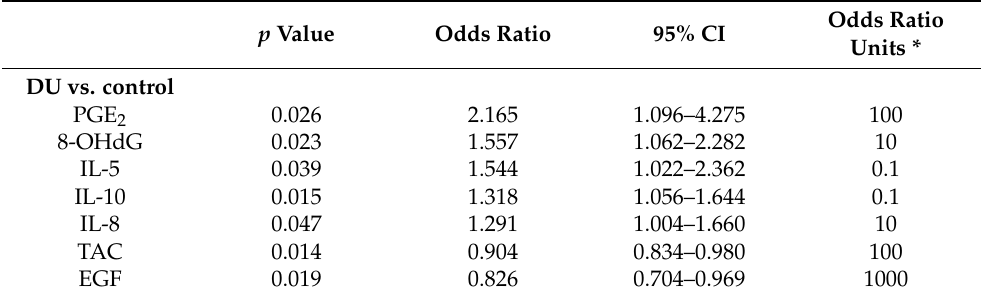
PGE2, prostaglandin E2; 8-OHdG, 8-hydroxy-2-deoxyguanosine; TAC, total antioxidant capacity; EGF, epidermal growth factor; *: units: all pg/mL, except for ng/mL in 8-OHdG and mmol/ µ L in